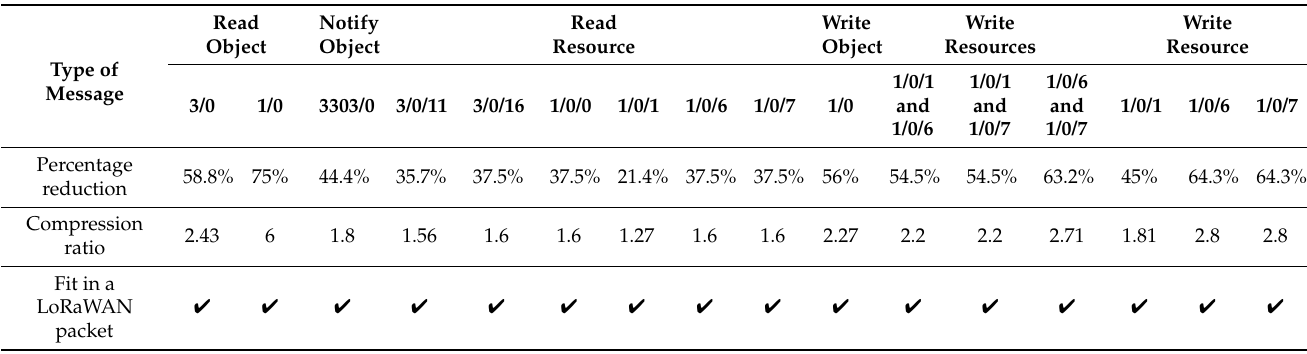
Table 3. Compression